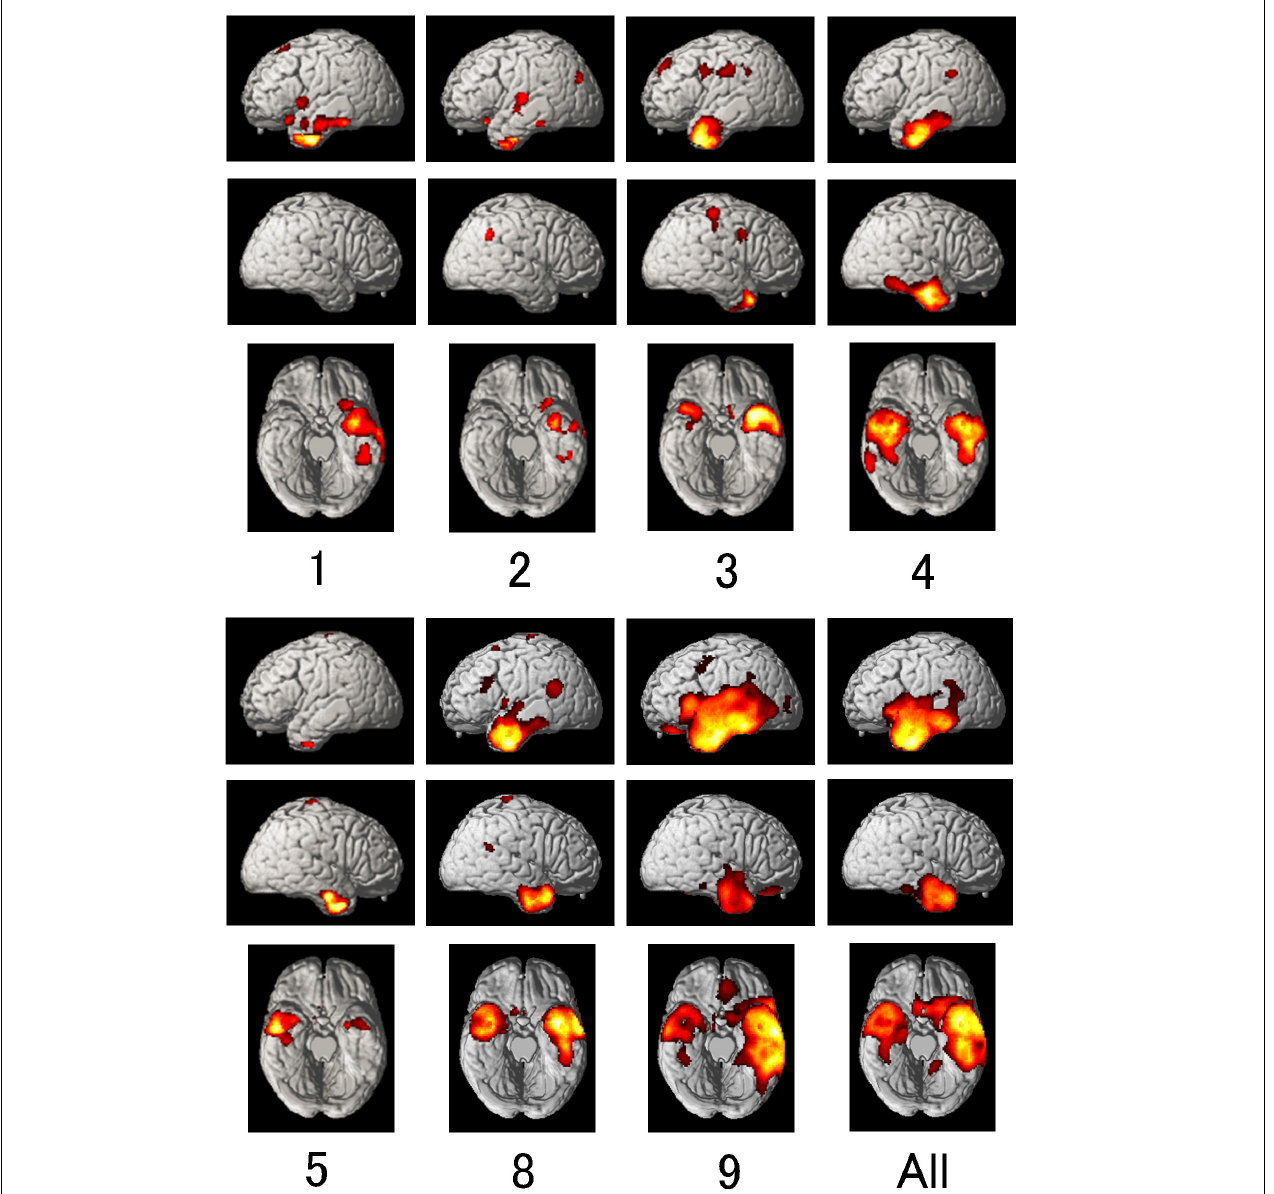
FIGURE 6 | ECD-SPECT images of the 7 patients individually and altogether. Number corresponds to the patient number in Table 1 . Each patient’s images were compared with those of normal subjects of the same generation and sex, using easy Z-score Imaging System (eZIS) and Statistical Parametric Mapping version 2 (SPM2). Areas of hypoperfusion (uncorrected p < 0.001 on t -test for individual analyses and analysis of covariance for all patients) are presented with a red-to-yellow gradient representing increasing z-scores. Temporal lobe hypoperfusion was left-predominant (Patients 1–3, 8, and 9), right-predominant (Patient 5), and left-right nearly equal (Patient 4). Averaged surface images revealed left-predominant hypoperfusion, involving the left posterior inferior frontal gyrus and anterior temporal lobe extending to the mid-fusiform gyrus. Areas with local maximum blood flow reduction in the temporal lobe were the left anterior and middle inferior temporal gyrus and mid-fusiform gyrus [Brodmann area (BA) 20; (–40, –4, –40), (–42, –24, –28), (–46, –42, –26)] and the right anterior temporal pole and middle and inferior temporal gyrus [BA 21; (42, 12, –32), (56, –8, –22), (42, –8, –34)] on the Montreal Neurological Institute (MNI)